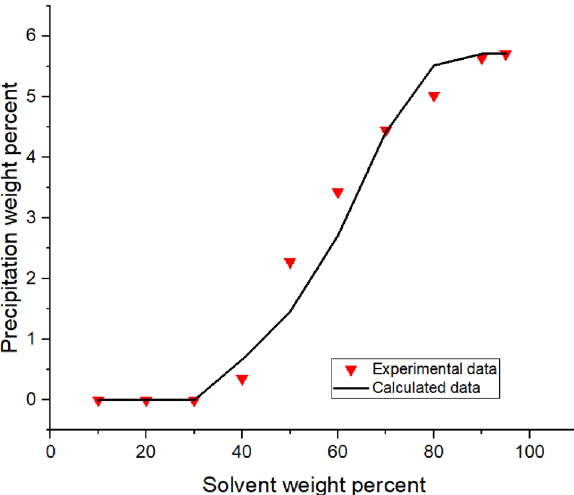
Figure 4. Asphaltene precipitation from the oil sample D versus solvent percent: obtained from experimental and modeling